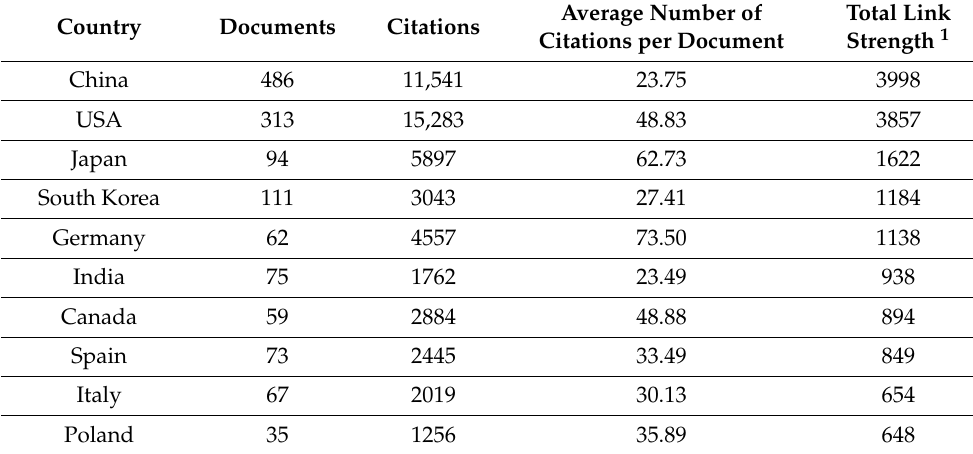
Table 1. The number of documents and citations of top 10 countries.